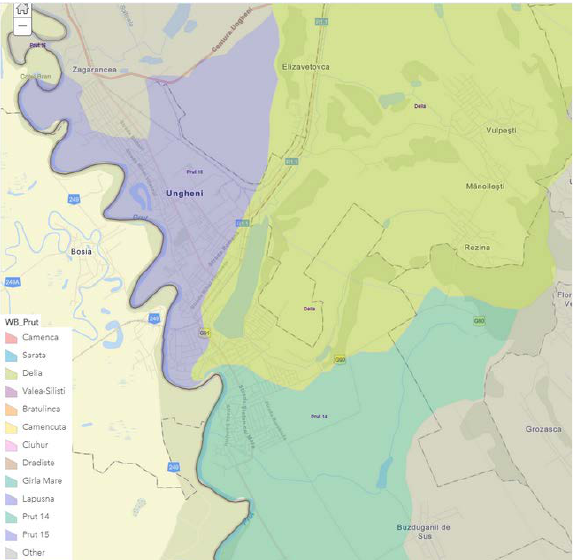
Figure 6. The Water Bodies that intersect the Ungheni municipality. Source: